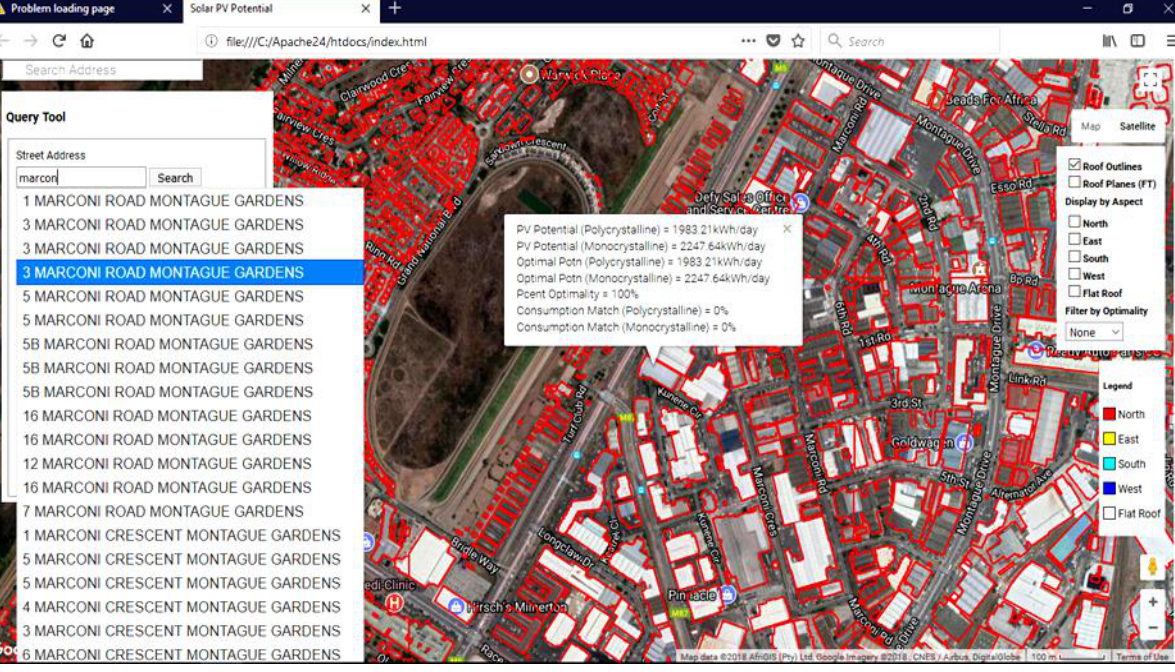
Figure 5. Screenshot 1 of the prototype web-based tool